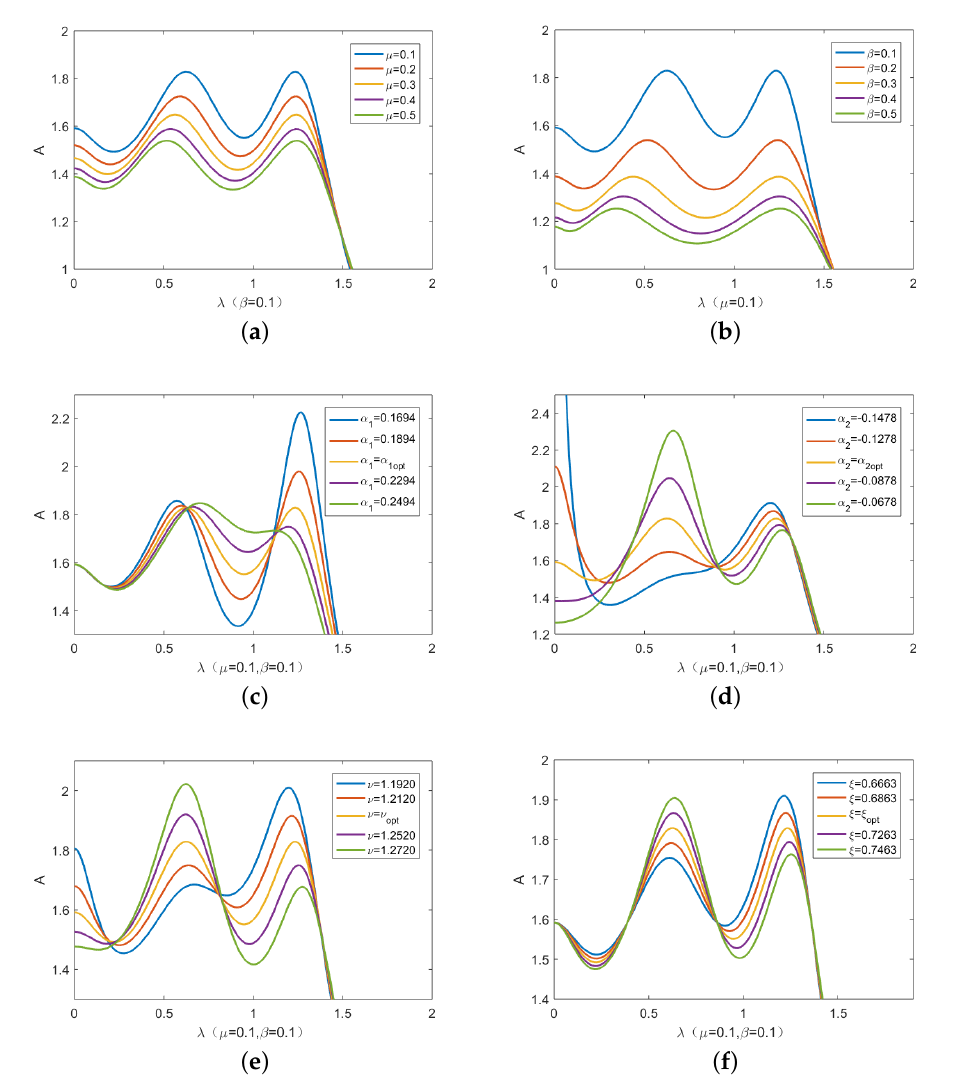
Figure 11. The optimal parameters verification when optimizing the single variable ξ : ( a ) change µ ; ( b ) change β ; ( c ) change α 1 ; ( d ) change α 2 ; ( e ) change ν ; ( f ) change ξ